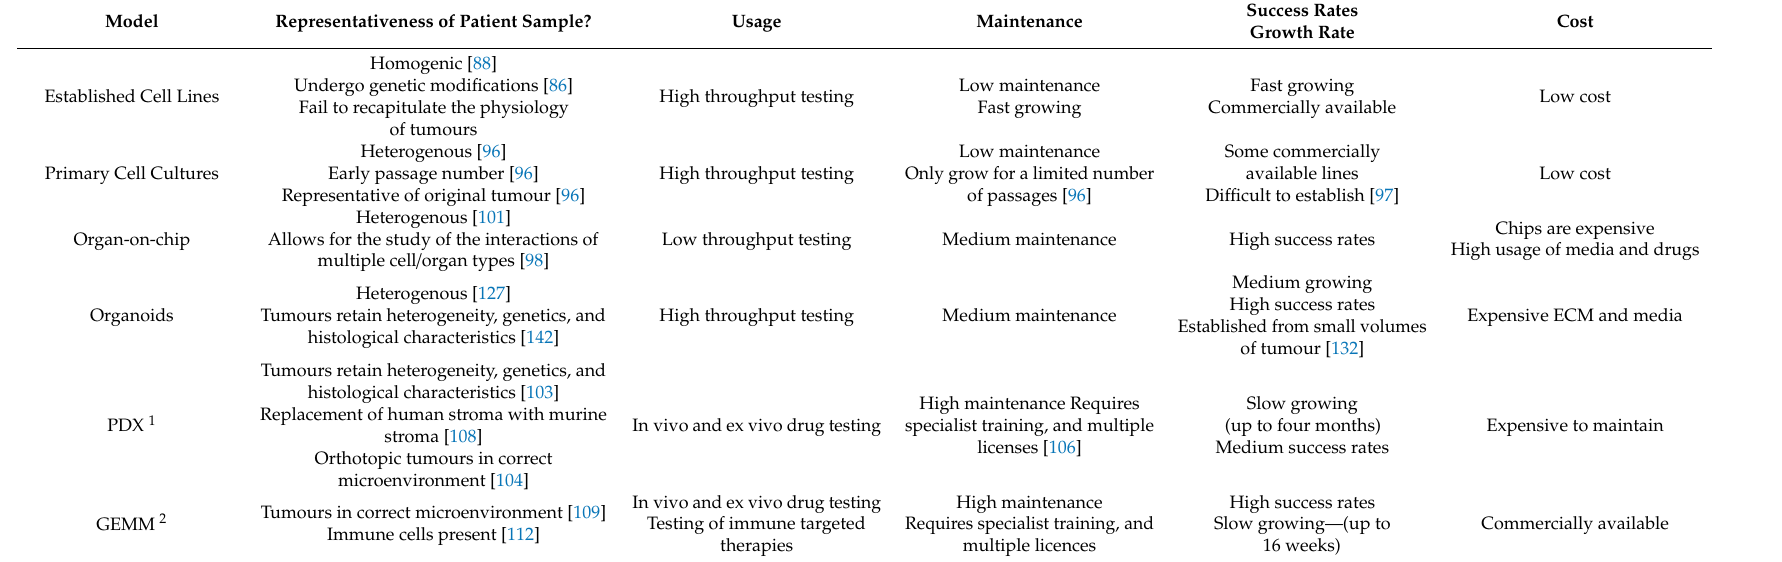
Table 3. An overview of the advantages and disadvantages of currently available PDAC